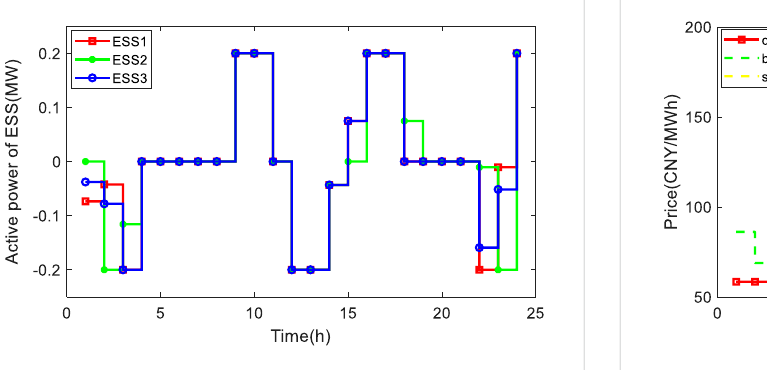
FIGURE 4 Control result diagram of energy storage charge and discharge.